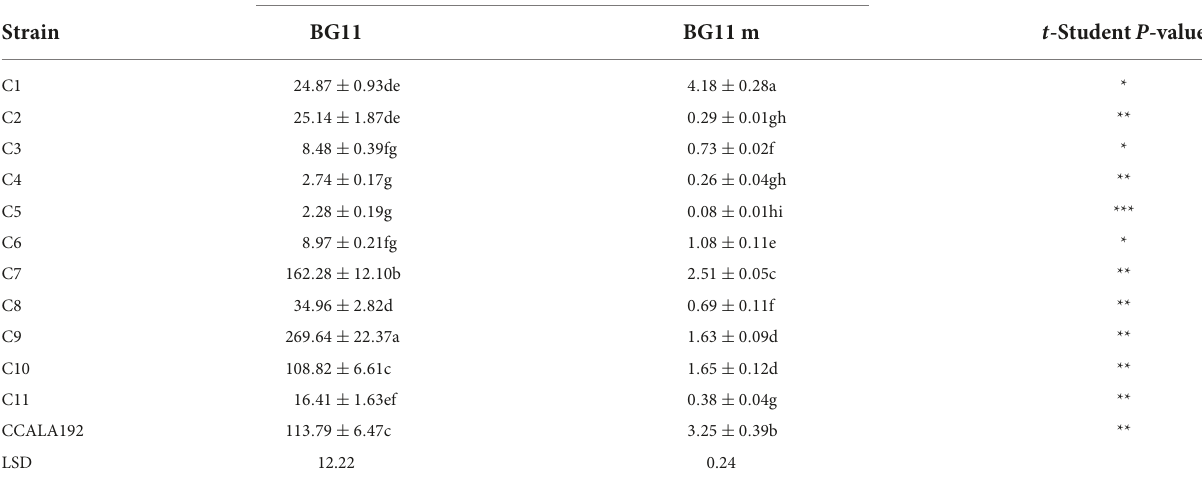
TABLE 2 Chlorophyll a contents recorded for “Stiffe” caves’ cyanobacteria and Synechocystis cf. salina , grown in BG11 0 and BG11 modified for